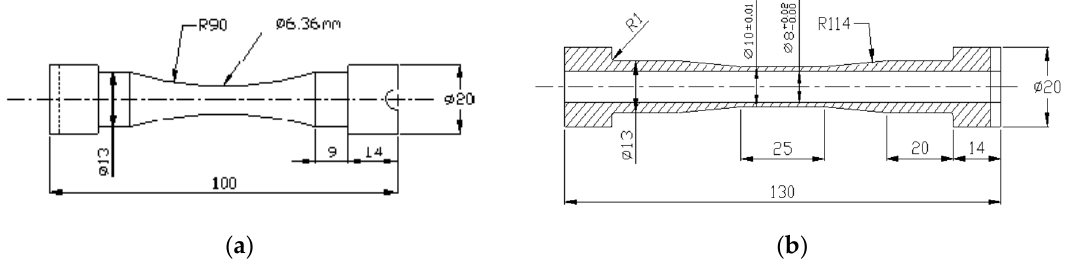
Figure 7. ( a ) Solid cylindrical toroidal specimen [2]; ( b ) tubular cylindrical specimen [2].